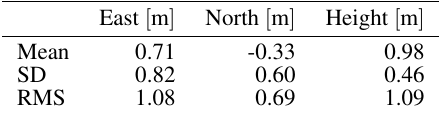
Table 1. Statistics of the differences between the image positions Table 2. Statistics of the differences between the image from the UAV telemetry and those estimated in the reference solution.